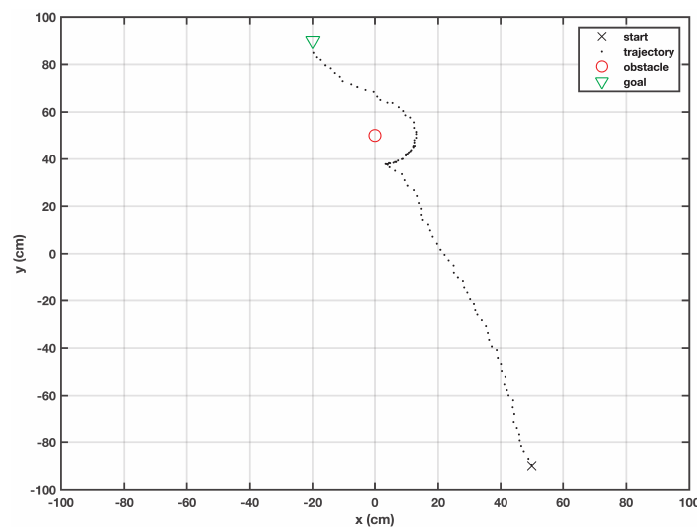
Figure 2. Trajectory of the robot when a static obstacle is encountered.